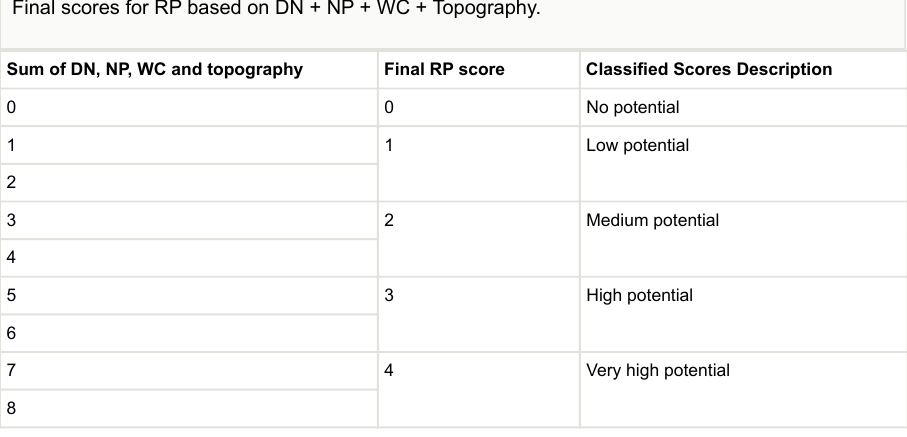
Final scores for RP based on DN + NP + WC +